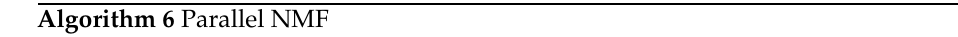
Algorithm 6 Parallel NMF